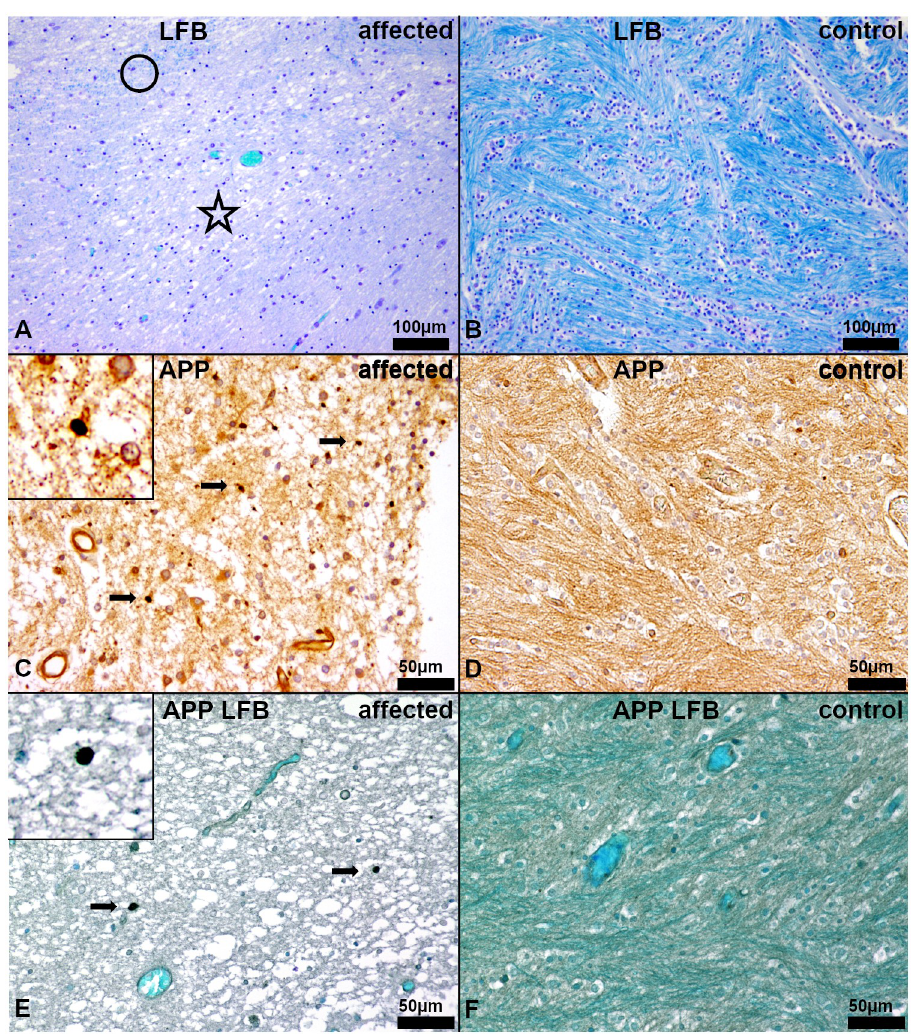
Fig 4. Histochemistry and immunohistochemistry of the white matter in the centrum semiovale of the cerebrum. (A, C, E) Affected puppy no. 1 and (B, D, F) age matched healthy control no. 1009. (A) Severe, diffuse lacking bluish staining, indicating myelin loss and edema in the centrum semiovale (asterisk). Only single fine strands of myelin can be detected (circle). (LFB). (B) Regularly developed myelin characterized by prominent bluish staining in the white matter (dark blue). (LFB). (C) Areas of severe myelin loss in the diseased puppies reveal low numbers of damaged axons (arrows). Vacuolization and loosening of the parenchyma indicate moderate edema. Inset shows a damaged axon at a higher magnification. ( β -amyloid precursor protein, APP). (D) No axonal damage is detectable in healthy control animals. (APP). (E) Severe, diffuse lacking blue-greenish staining, indicating myelin loss and edema, in the centrum semiovale , containing low numbers of damaged axons (arrows). Vacuolization and loosening of the parenchyma represent the moderate edema. Inset shows a damaged axon at a higher magnification. (APP, LFB). (F) Regularly developed myelin characterized by prominent blue-greenish staining in the white matter (dark teal) without any damaged axons. (APP, LFB).